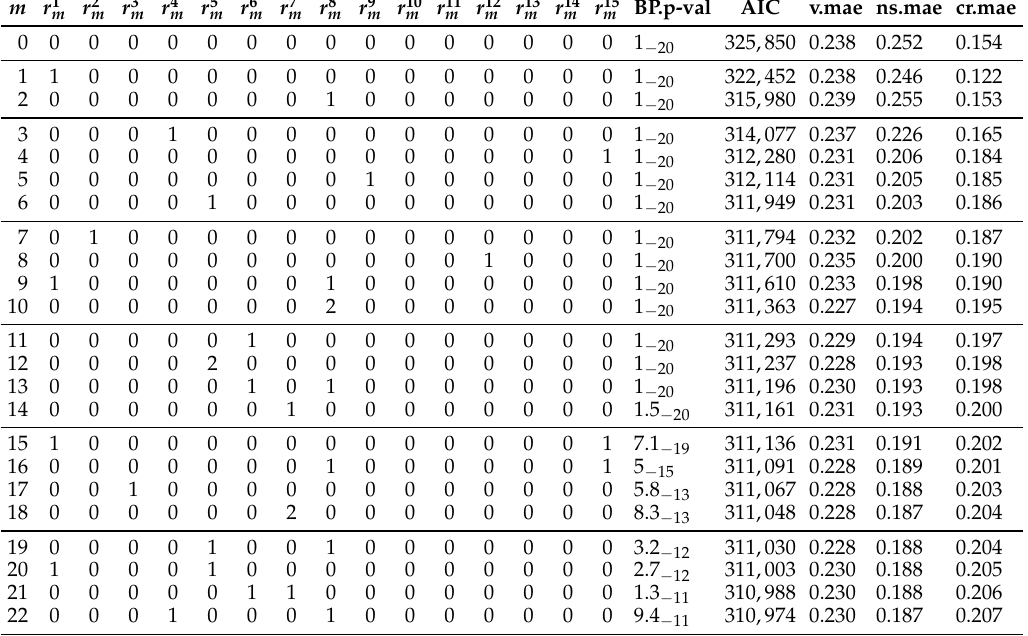
Table A24. Feasible generalized least-squares (FGLS) variance models of BEL corresponding to M max 2,6,10,14,18,22 derived by adaptive selection from the set of basis functions of the 150–443 OLS { } proxy function given in Table A1 with exponents summing up to at max two. Furthermore, p -values of Breusch-Pagan test, AIC scores and out-of-sample MAEs in % after each iteration.